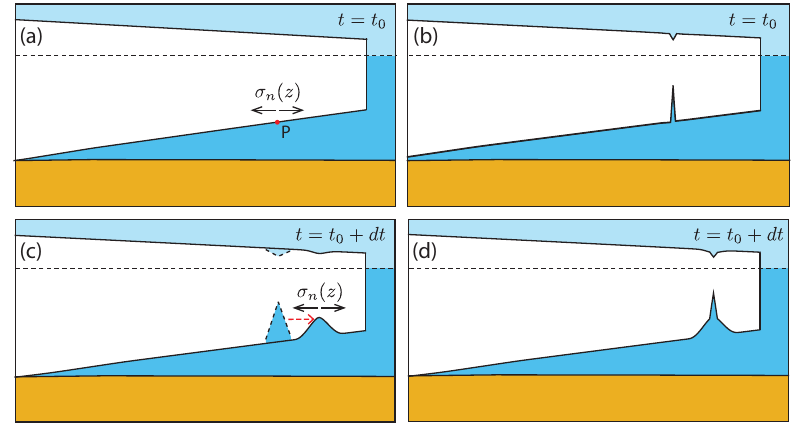
Figure 4. Schematic of the combination of ISSM and LEFM: (a) initial condition; (b) crevasses propagate; (c) crevasses advect downstream; (d) crevasses